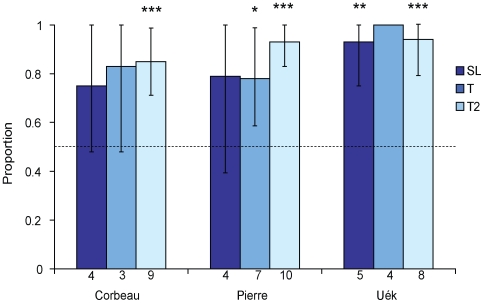
Tool ‘swaps’ in Experiment 2.Bars show the proportion of ‘positive’ tool swaps (exchanging a short tool for a longer one) compared with the expected proportion from random swapping (0.5; shown by the dashed horizontal line). Data are only for successful trials with at least one tool swap, excluding all swaps from the tabletop tool to an extracted tool (since by definition these swaps will always be positive); there were no swaps in SA trials. The number of relevant trials is displayed underneath each bar. Error bars show 95% confidence intervals and are capped at 1 (in the four relevant Tertiary trials for Uék, only positive tool swaps were made, hence the lack of an error bar). P-values (two-tailed) from one-sample t-tests of the observed and hypothesized proportions (p-values adjusted for each subject) are indicated by asterisks: * = p<0.05, ** = p<0.01, *** = p<0.001. Trial types are coded as in Figures 4 and 5, with the exception that no SA trials are presented.